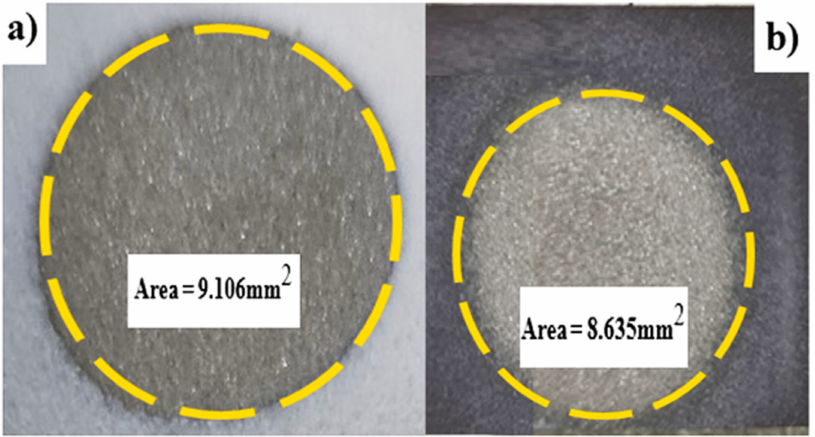
Figure 7. Comparison of erosion craters of A90-P0 ( a ) and A80-P10 ( b ) coatings after testing for resistance to erosion.